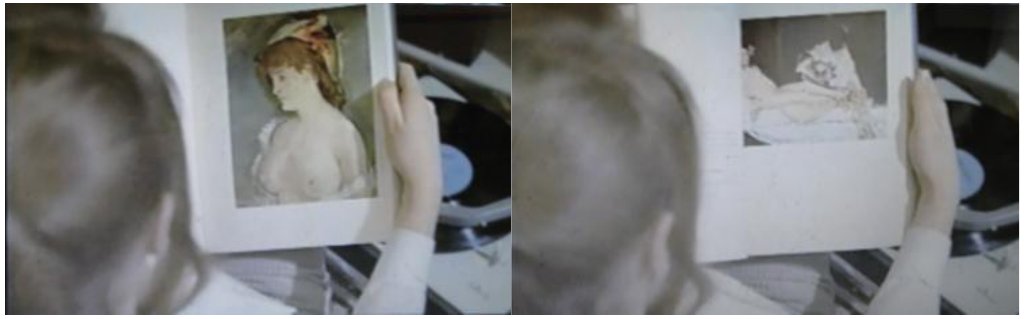
Figure 4: Two shots of Bresson’s gentle woman regarding an art book with paintings by Manet (on the right, La Blonde aus seins nus ; on the left, Olympia